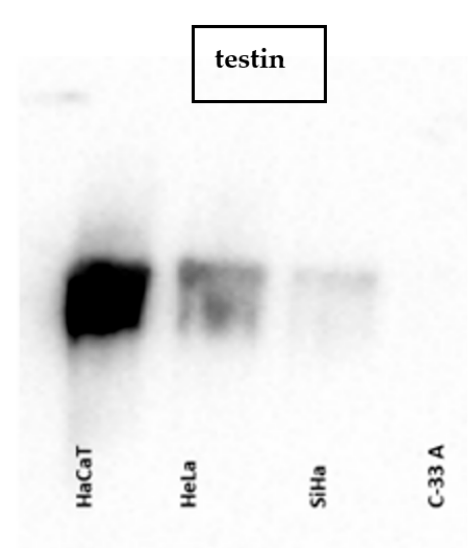
Figure 3. WB: testin expression in HaCat, HeLa, SiHa and C-33 A cell lines.